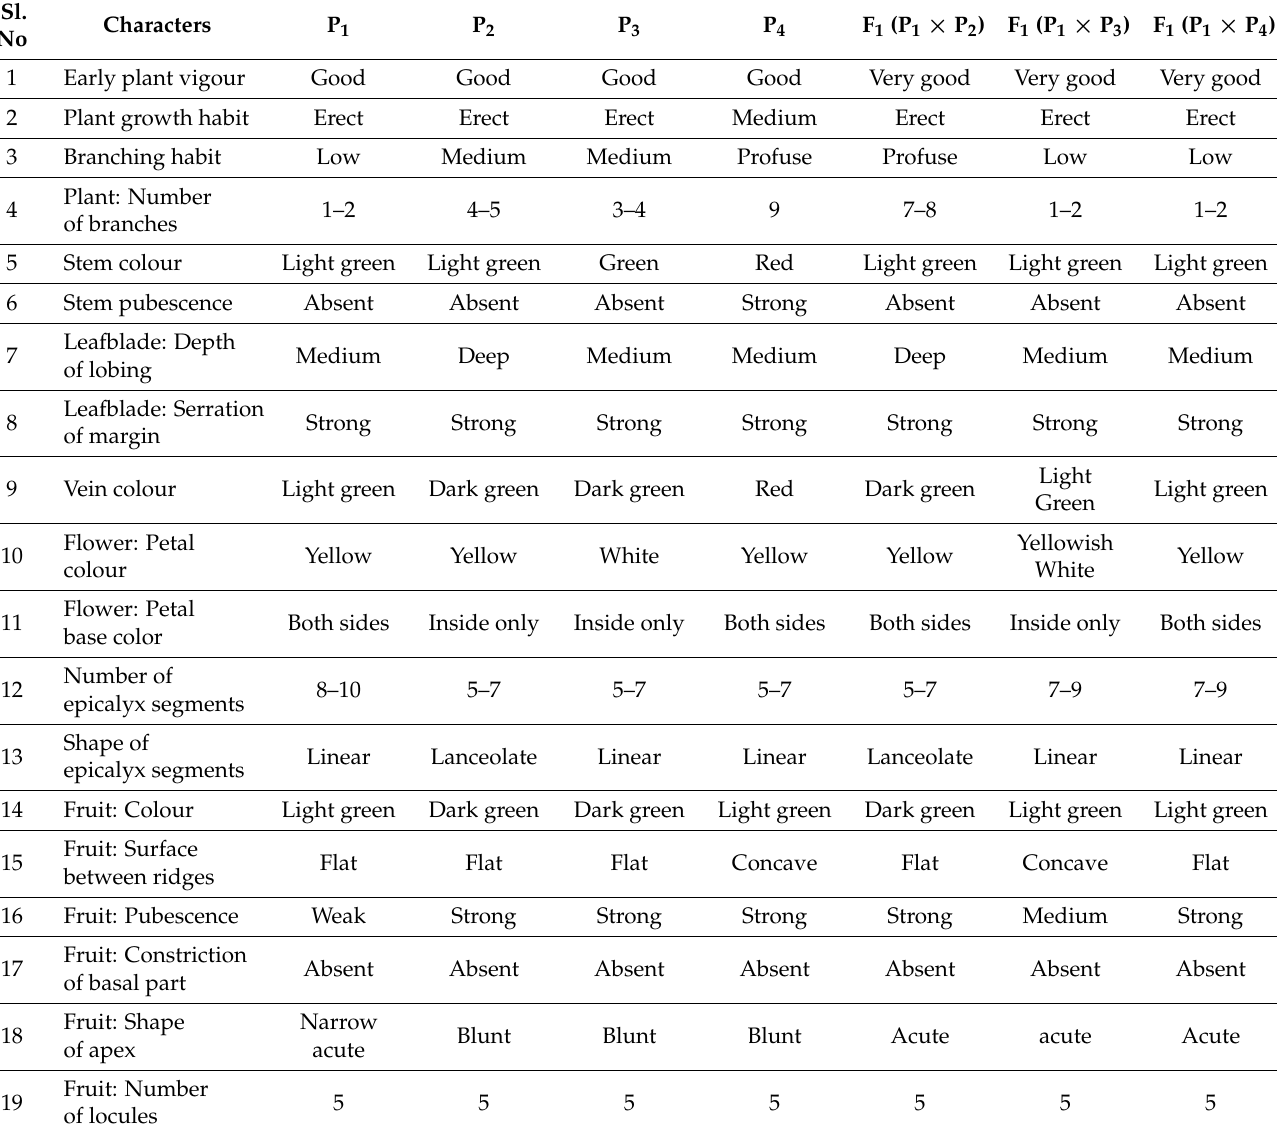
Table 4. Morphological Characterization of qualitative traits of interspecific F 1 hybrids of Abelmoschus species with their